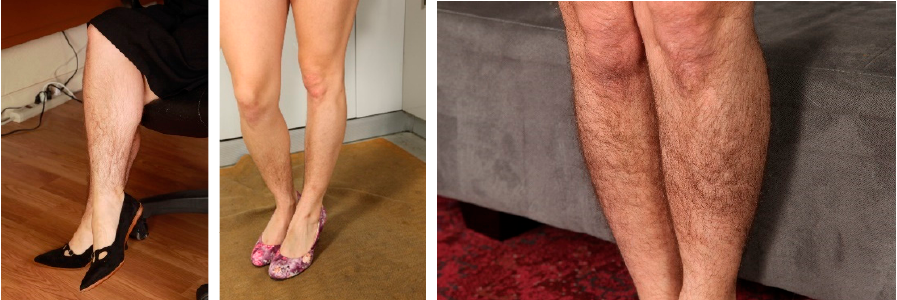
Figure 1. “Leg” images obtained by the data-mining process.